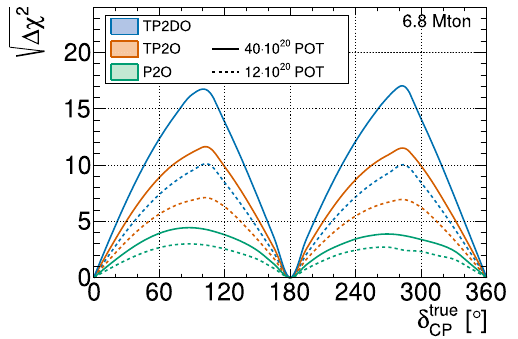
Fig. 8 Sensitivity to exclude the no-CP violation hypothesis as a func- tion of the true δ CP value for P2O (green), tagged P2O (red) and tagged P2O with a far detector with a photocathode density twice as large as KM3NeT/ORCA (blue). The solid lines correspond to an exposure of 40 · 10 20 POT and the dashed ones to 12 · 10 20 POT